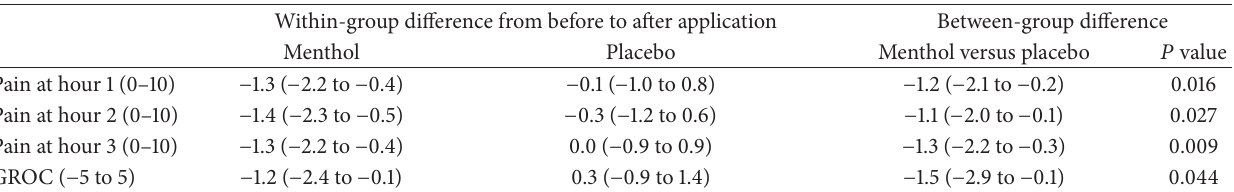
Table 2: Changes in arm/hand pain intensity and global rating of change (GROC) following menthol and placebo topical application. Differences of each group are shown on the left and post hoc contrasts between the groups on the right. Values are means (95% confidence interval).